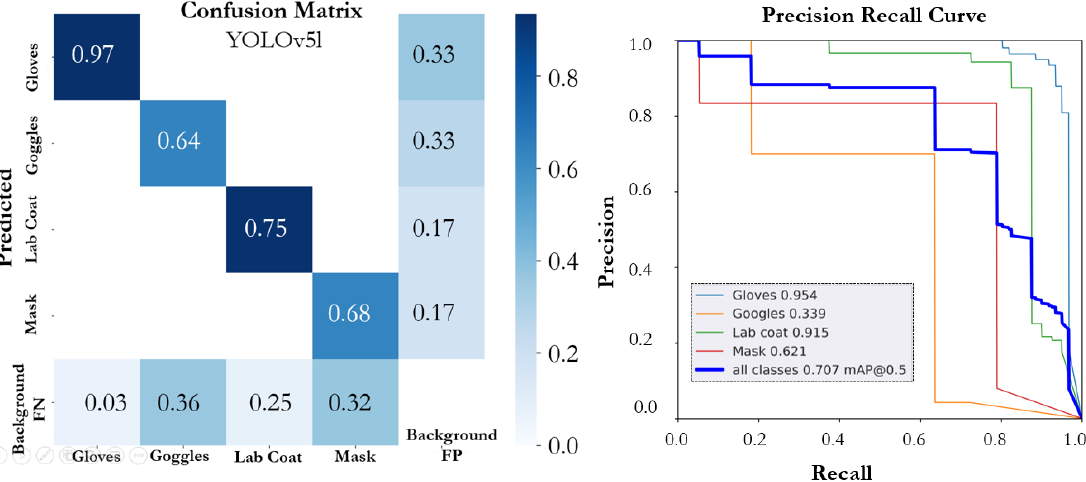
Figure 11. Confusion matrix and PR curve of the YOLOv5l model.